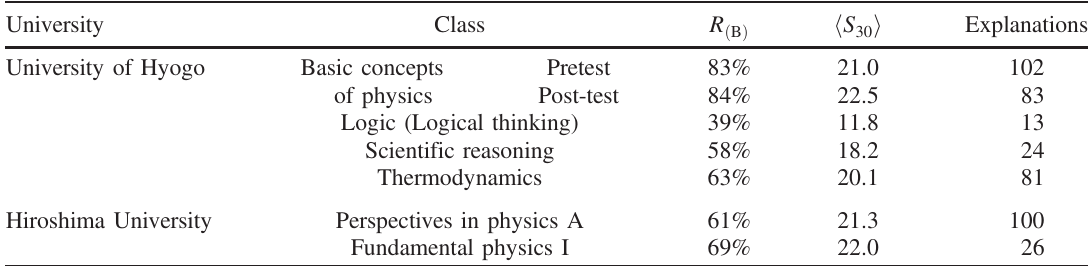
TABLE II. Classes of respondents and number of explanations on Q.29.